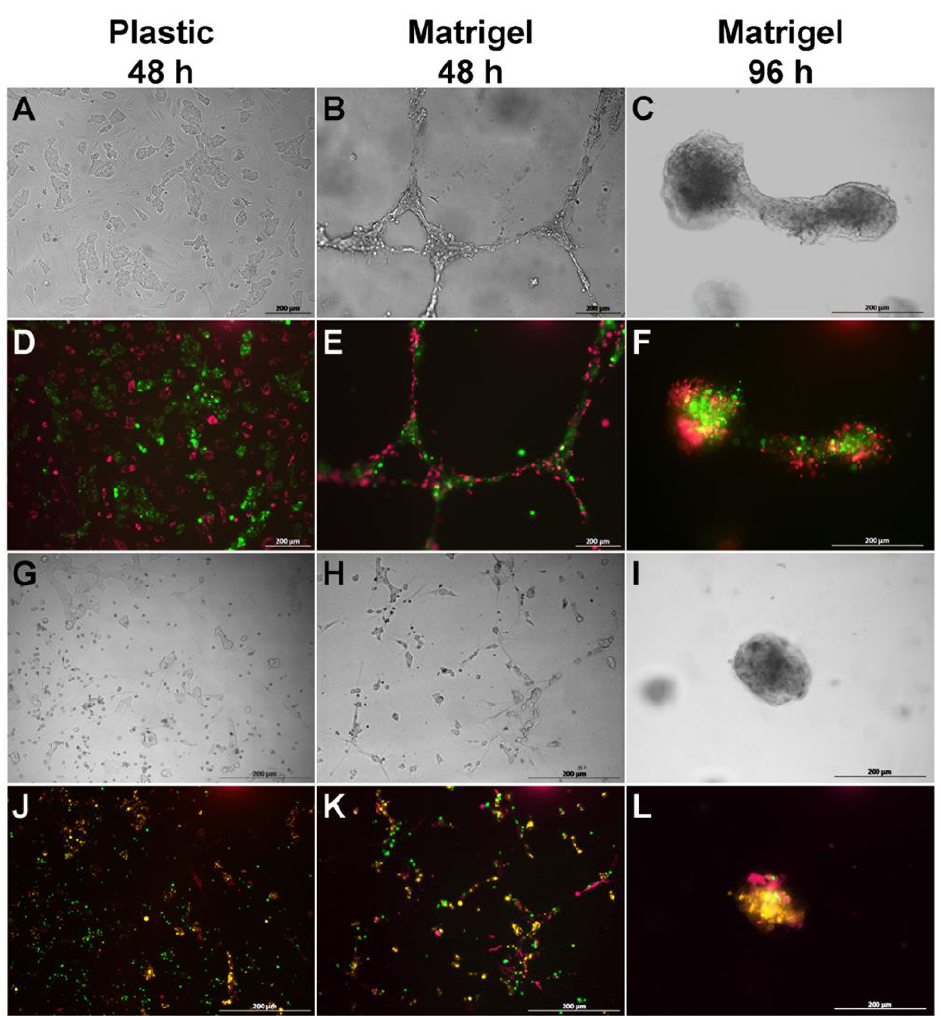
Figure 3. Self-organization of BM-MSCs, PBMCs, and SH-SY5Y cells in co-culture on untreated plastic and Matrigel. ( A – C , G – I ) Phase contrast light microscopy. ( D – F , J – L ) Fluorescence microscopy. ( A – F ) Double co-culture contains SH-SY5Y cells (FITC, green) and BM-MSCs (Alexa Fluor 647, red). ( G – L ) Triple co-culture contains SH-SY5Y cells (PE, yellow), BM-MSCs (Alexa Fluor 647, red), and PBMCs (FITC, green). ( D – F , J – L ) Fluorescence microscopy: alignment of the fluorescence spectra of Alexa Fluor 647 (BM-MSCs, red), PE (SH-SY5Y cells, yellow), and FITC (PBMCs, green). Scale: 200 µm.